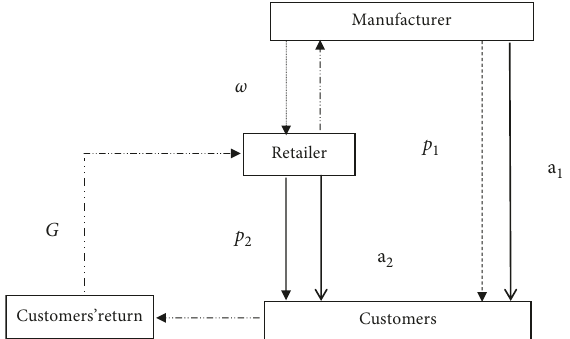
Figure 1: The O2O CLSC distribution